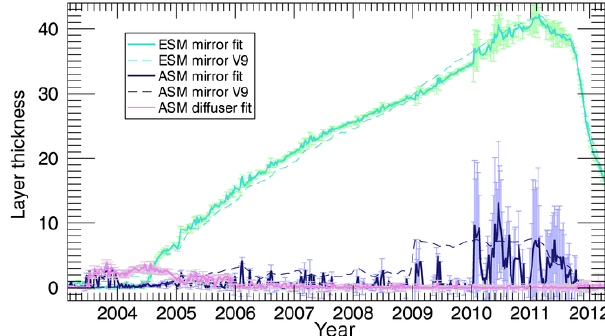
Figure 7. Contamination layer thicknesses of the ESM mirror, ASM mirror, and ASM diffuser as a function of time (mission lifetime in orbit). For each optical element, two data sets are shown: dashed lines indicate the layer thicknesses of the ESA V9.01 degradation correction, and bold lines (including error bars) show the layer thicknesses derived with the modified degradation model from this